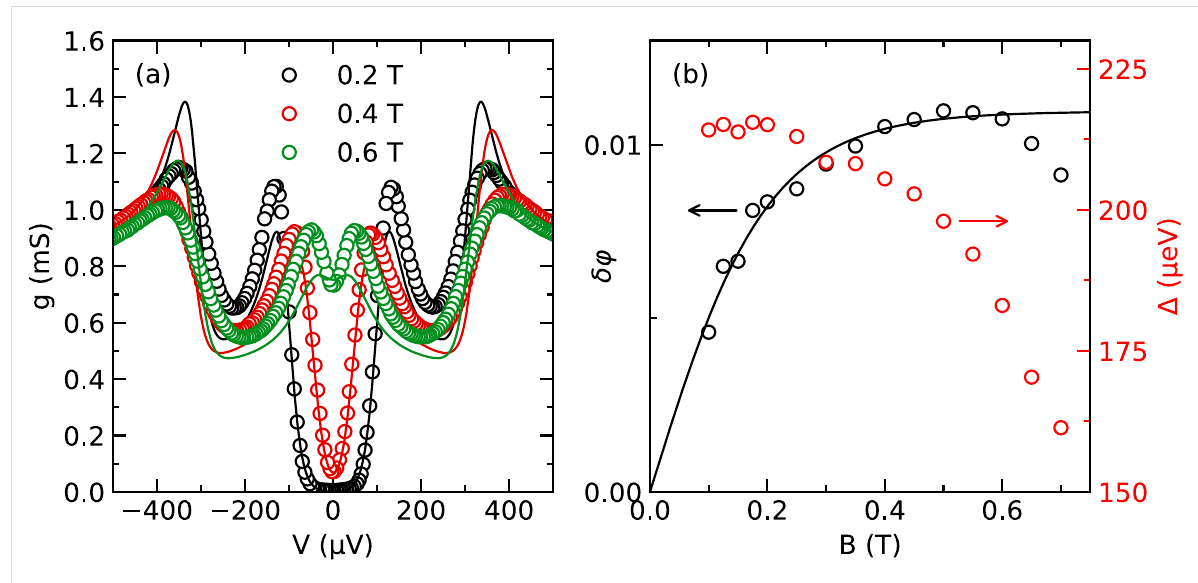
Figure 5: (a) Differential conductance g as a function of the bias V for different applied magnetic fields B (symbols), and fits with our model (lines). (b) Spin mixing angle δφ (left axis) and pair potential Δ (right axis) as functions of the applied field B extracted from the fits (symbols), and fit of the spin mixing angle with a Brillouin function (line).